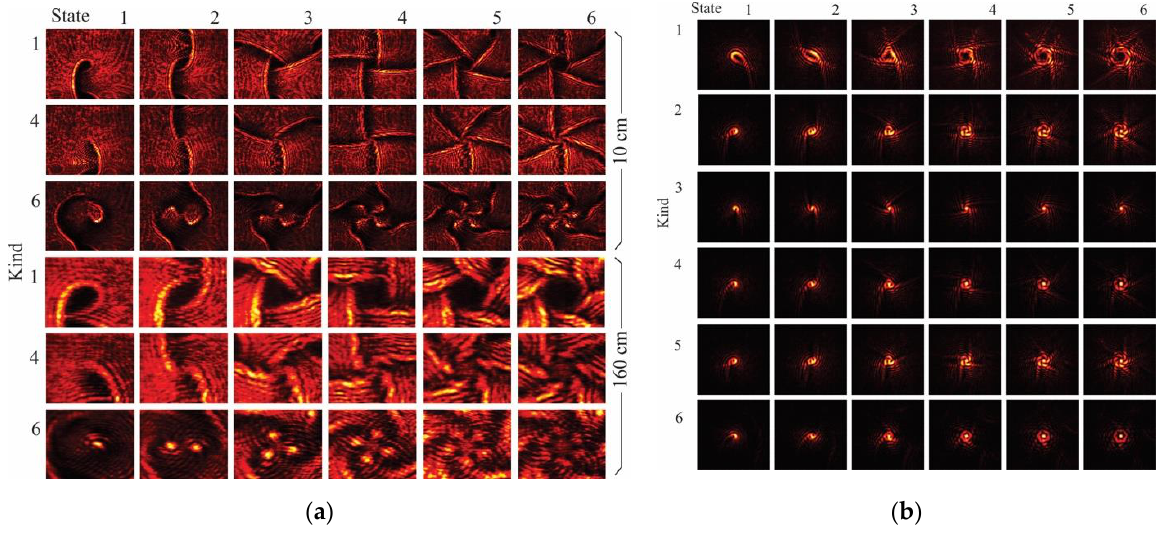
Figure 5. ( a ) Propagation of Kinds 1, 4 and 6 at distances 10 and 160 cm, and states (cid:96) = 1 to 6. ( b ) Images obtained from